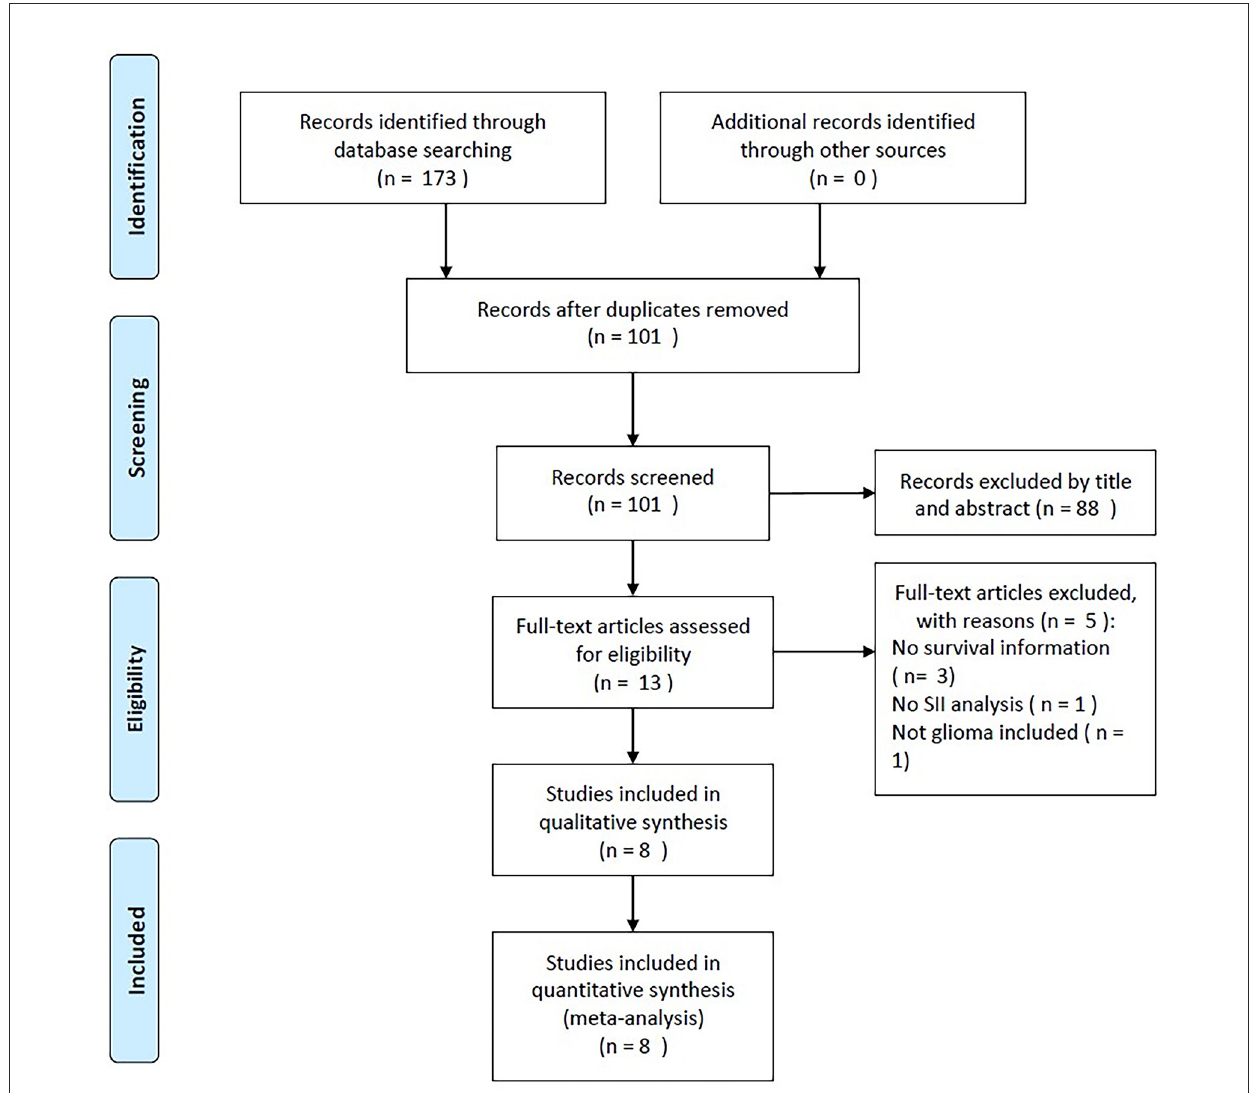
FIGURE1 Flowchart of literature